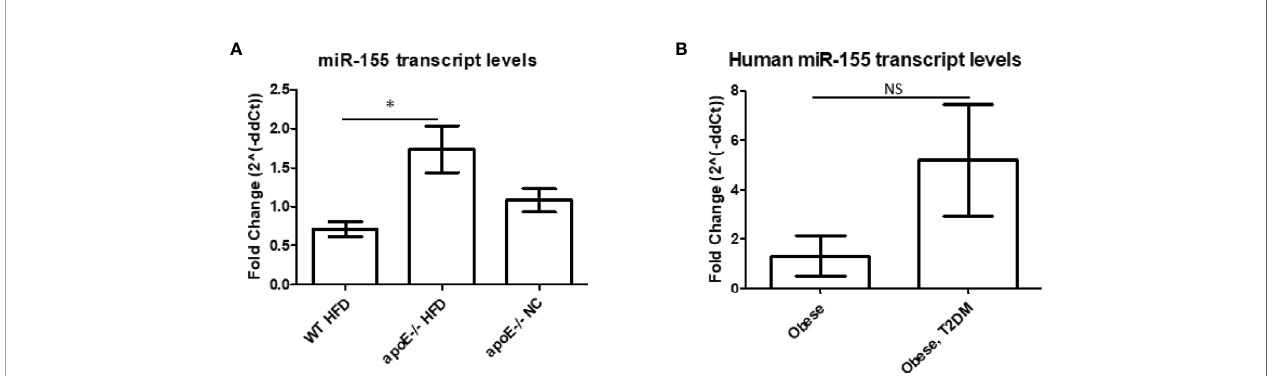
FIGURE 1 | MicroRNA-155 transcripts are decreased in white adipose tissue (WAT) of obese wild-type (WT) mice compared with WAT of apolipoprotein E (ApoE) -/- mice. (A) Mice were kept on either normal chow (NC) or switched to high-fat diet (HFD) at 8 weeks old and fed for an additional 12 weeks. ApoE -/- NC (n=6); apoE -/- HFD (n=7); WT HFD (n=4). * p < 0.05. (B) Obese patients with or without type 2 diabetes mellitus (T2DM). Donor information detailed in Table 3. Obese (n=2), Obese, T2DM (n=4). p > 0.05. NS, not signi fi